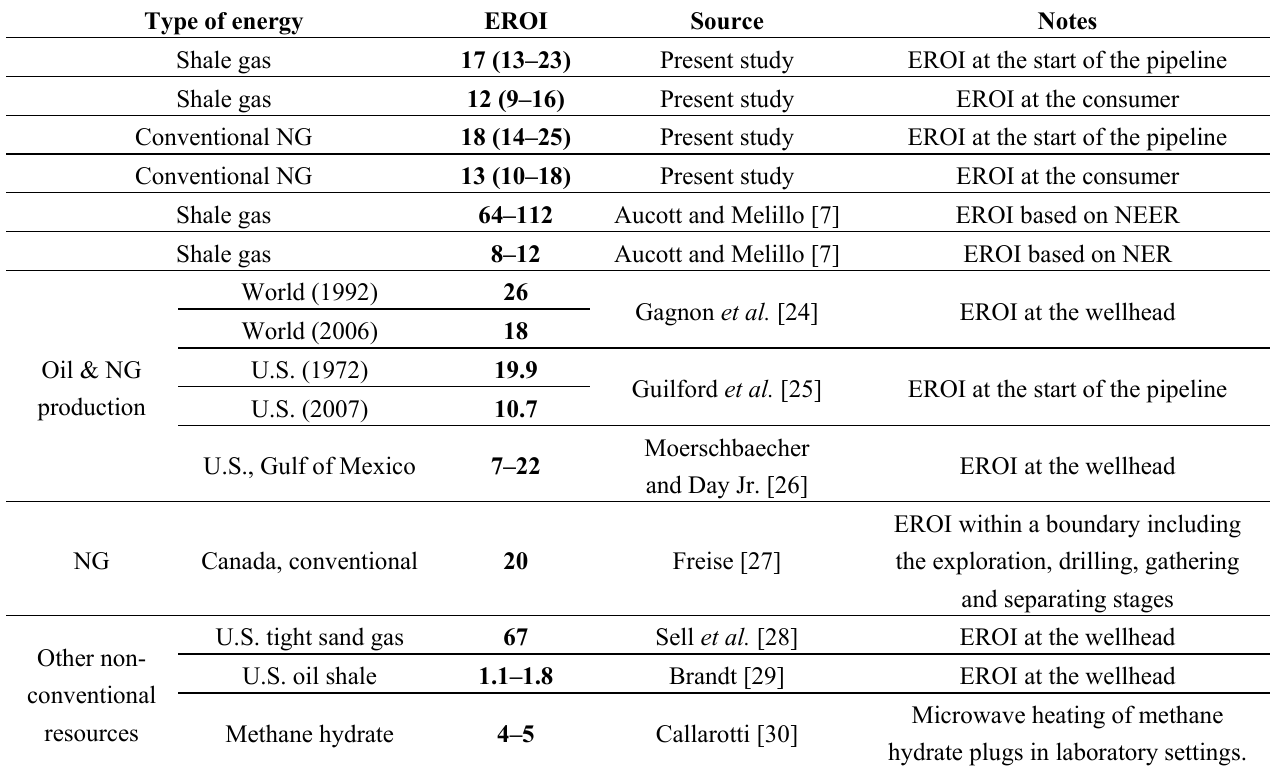
Table 7. Comparison of various oil and gas resource